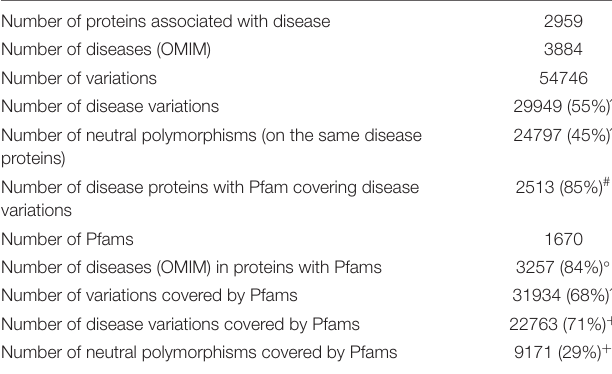
TABLE 1 | Summary of the OMIM-related variation dataset of this